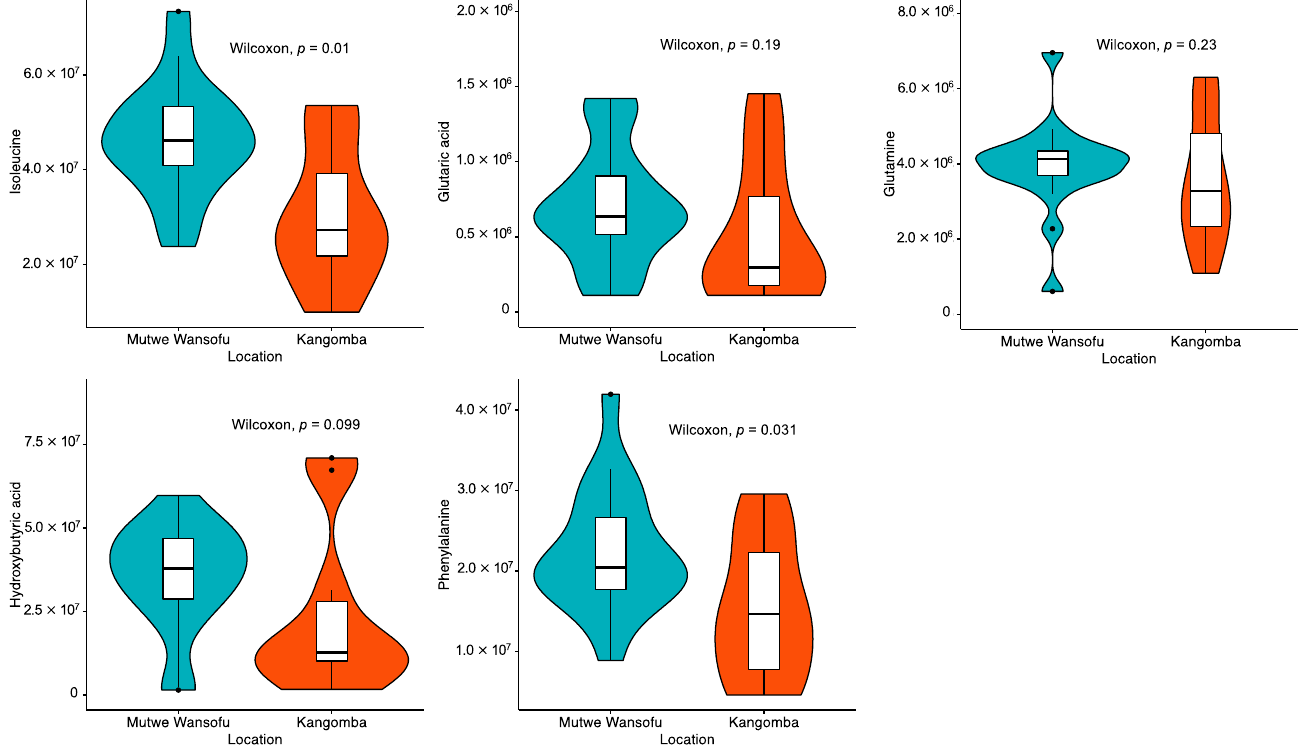
Figure 2. Comparison of the measured concentration (peak area) of plasma metabolites according to area.